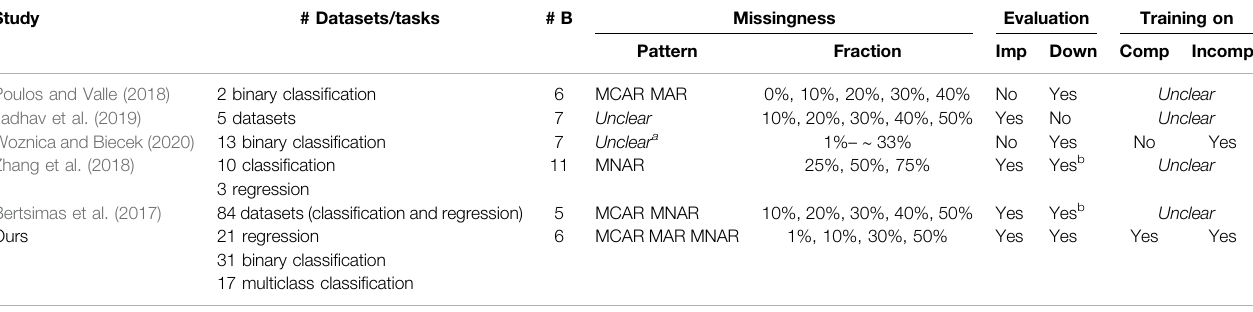
TABLE 1 | An overview of related benchmarks. In contrast to our benchmark, all other studies focus on speci fi c aspects such as downstream tasks or missingness conditions.Most importantly,no papersystematically compares imputation methods trained oncomplete and incompletedatasets. Abbreviations: thesymbol # stands for the number, B means baselines, Imp means imputation quality, Down means impact on the downstream task, Comp means complete data, Incomp means incomplete data.